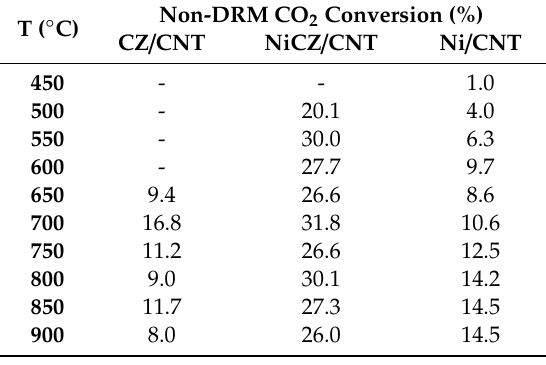
Table 2. The “non-DRM” conversion of CO 2 over CZ / CNT, NiCZ / CNT and Ni / CNT catalysts.